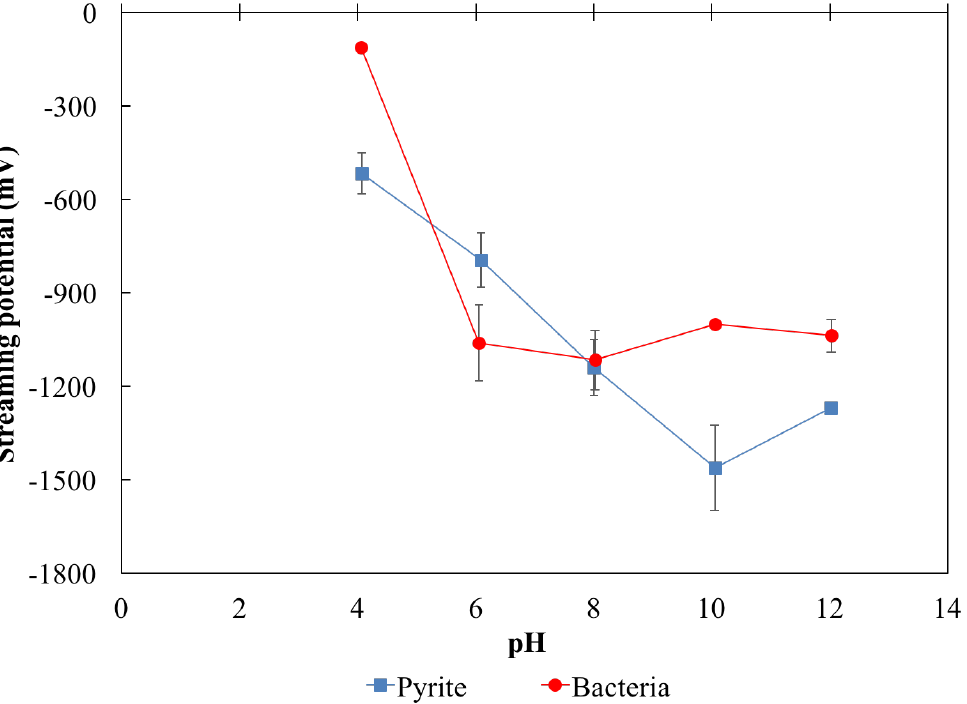
Figure 2. Streaming potential of A. ferrooxidans and pyrite in fresh water.